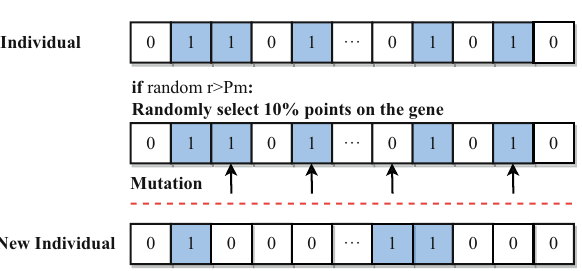
Fig. 8 Crossover process